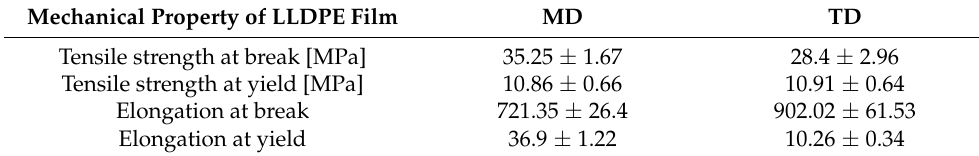
Table 1. Mechanical properties of manufactured plastic film in both MD and TD directions. Mechanical Property of LLDPE